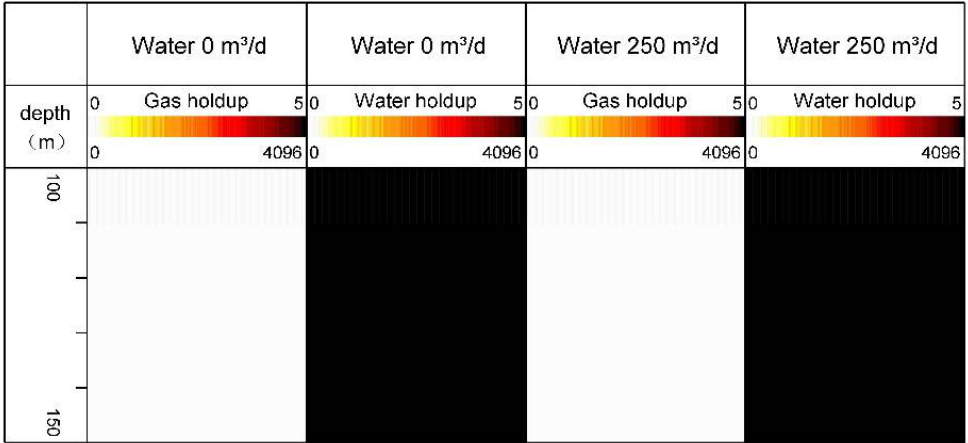
Figure 3. Response characteristics of pure water at 0 and 250 m 3 /d.